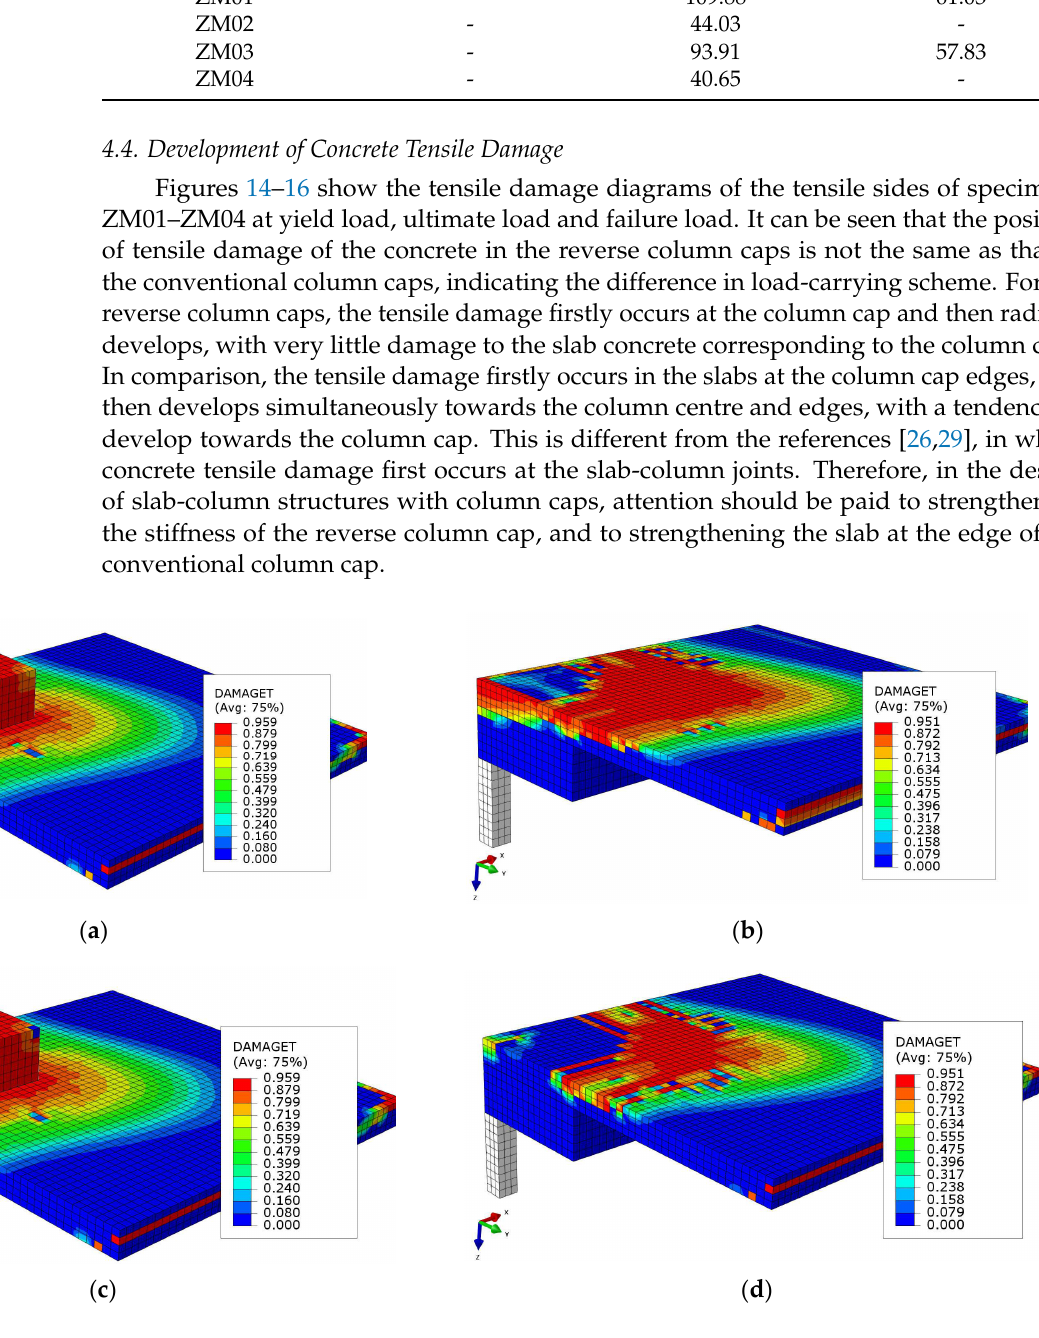
( d ) Figure 15. Tensile damage diagrams of tensile sides of specimens ZM01–ZM04 at ultimate load: ( a ) ZM01; ( b ) ZM02; ( c ) ZM03; and ( d ) ZM04. ( a )